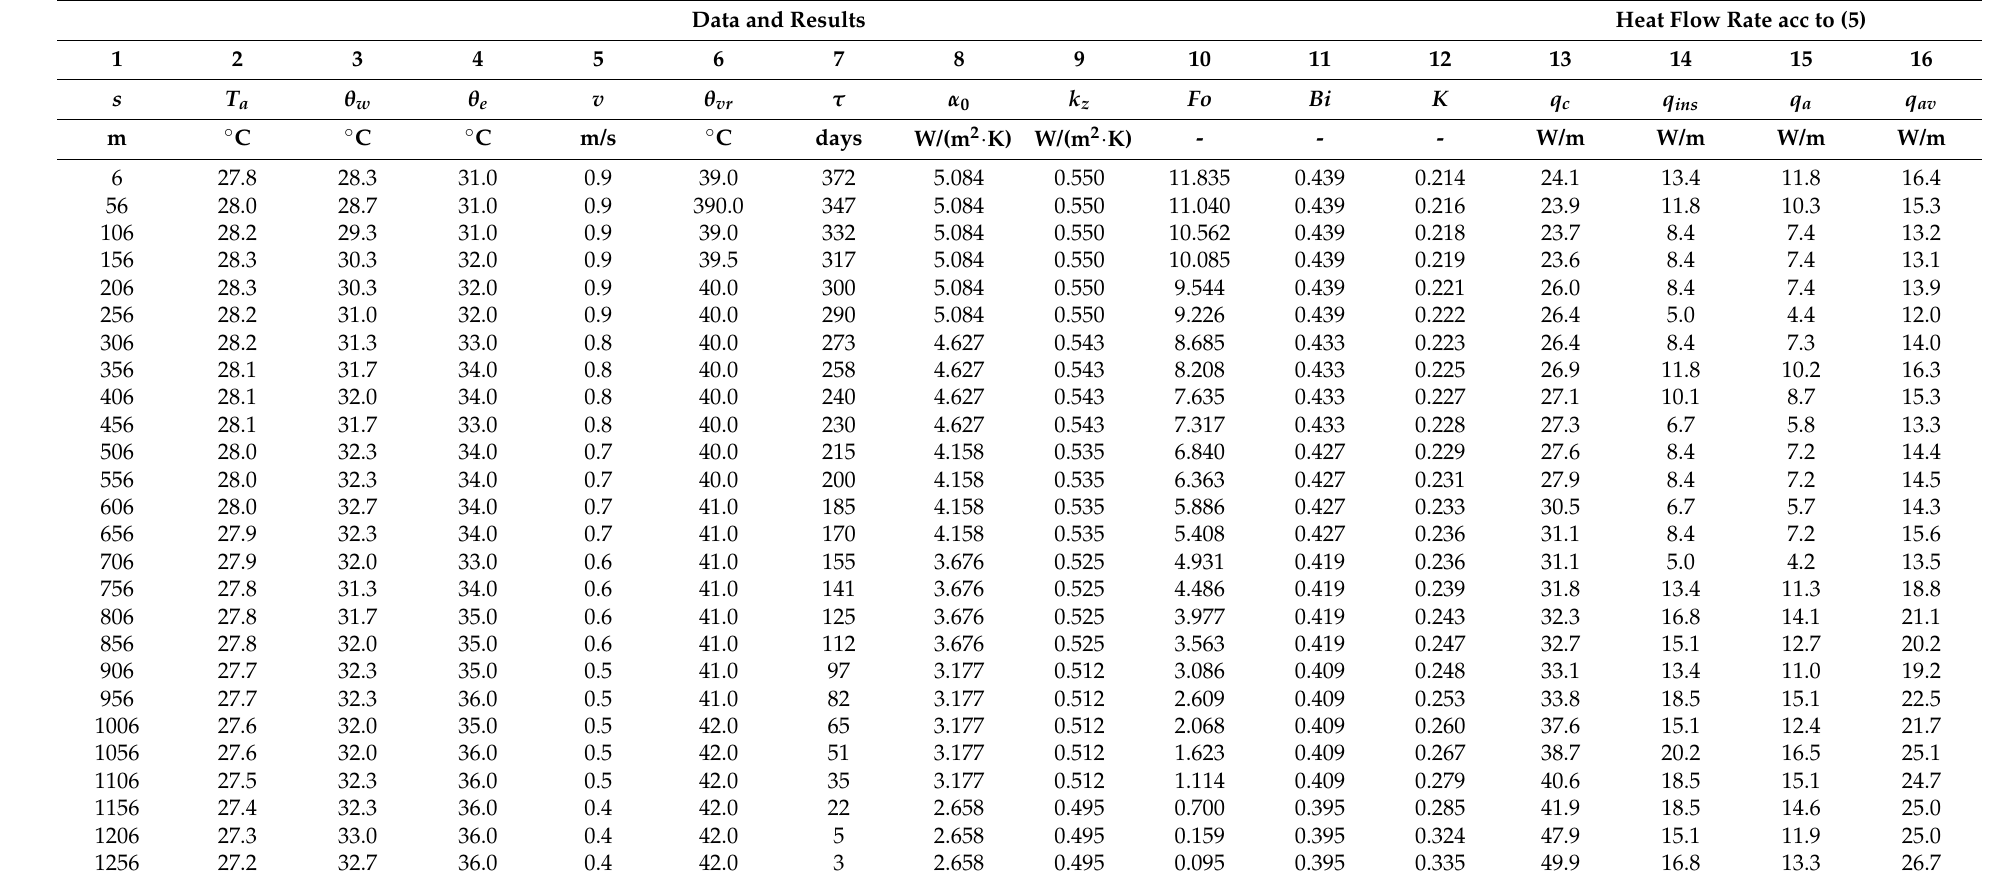
Table 1. Results of measurements and calculations of heat transfer through the insulation layer of the